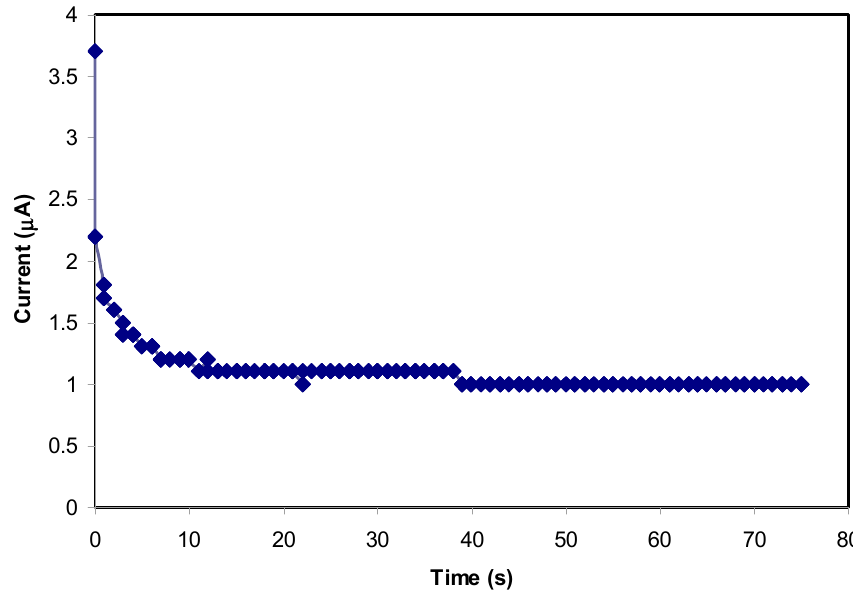
Figure 6. Polarization current for PCSH4 conduction sample versus time.